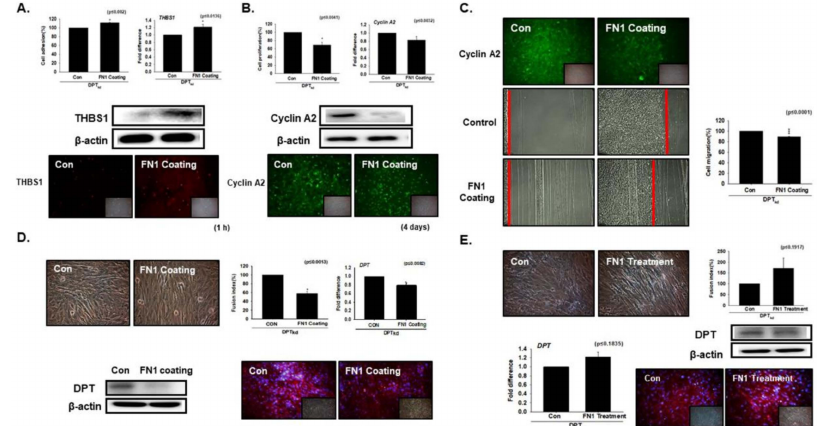
Figure 5. Compensation e ff ect of fibronectin with DPT knockdown. ( A ) DPT knock-down was performed and cells were cultured in 10% FBS with or without the FN-coated plate for 1 h. Cell adhesion or cell attachment was evaluated by MTT assay, THBS1 mRNA expression by real-time RT-PCR, and protein expression by Western blot and immunocytochemistry. ( B ) DPT kd cells were cultured in 10% FBS with or without FN-coated plate for 4 days. Cell proliferation was evaluated by MTT assay, Cyclin A2 mRNA expression by real-time RT-PCR, and protein expression by Western blot and immunocytochemistry. ( C ) Scratch assay was performed when cells reached a confluency of ~95%; cells were scratched in both plate (with and without FN-coated) and incubated for 3 more days. Di ff erences between the migration pattern of FN1 coated plate and non-coated (control) plate. Expression of Cyclin A2 protein were assessed by immunocytochemistry. ( D ) DPT kd cells were cultured with 2% FBS in 1mM FN-coated plate for 4 days. Myotube formation and fusion index were assessed by Giemsa staining, DPT mRNA expression by real-time RT-PCR, and protein expression by Western blot. ( E ) DPT kd cells were cultured in 2% FBS supplemented with 1 mM FN protein for 4 days. Myotube formation and fusion index were assessed by Giemsa staining, DPT mRNA expression by real-time RT-PCR, and protein expression by Western blot. * p ≤ 0.05, ** p ≤ 0.001, *** p ≤